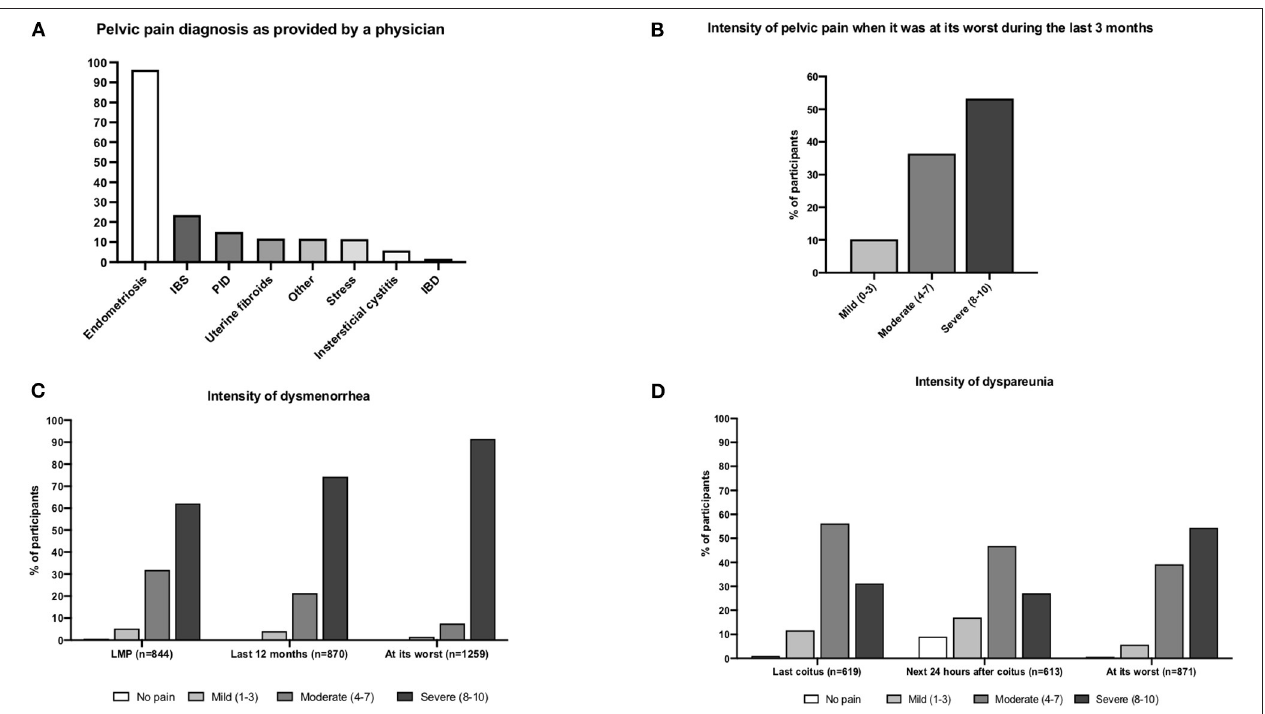
FIGURE 6 | Diagnosis and intensity of pelvic pain. (A) Pelvic pain diagnosis. (B) Intensity level of pelvic pain (last 3 months). (C) Intensity of level of dysmenorrhea. (D) Intensity level of dyspareunia.